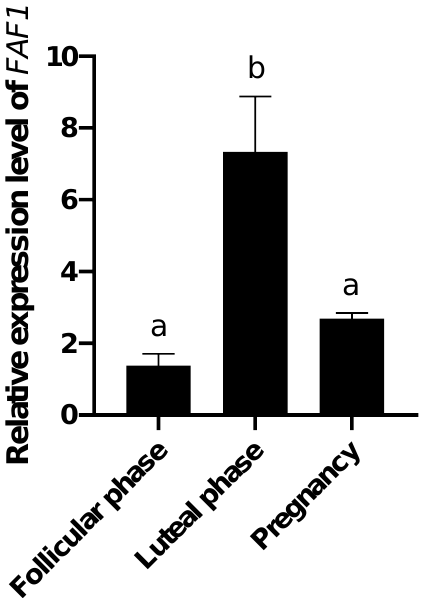
Figure 5. Relative expression of FAF1 mRNA in the ovaries of different reproductive cycle phases in B. grunniens (different letters indicate significantly different values at p < 0.05).